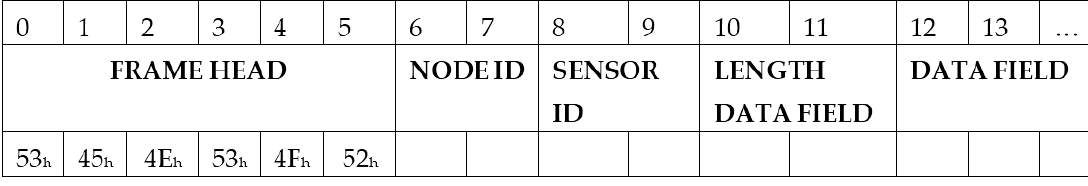
Table 2. Map of direction vector control events with two in-line sensors.